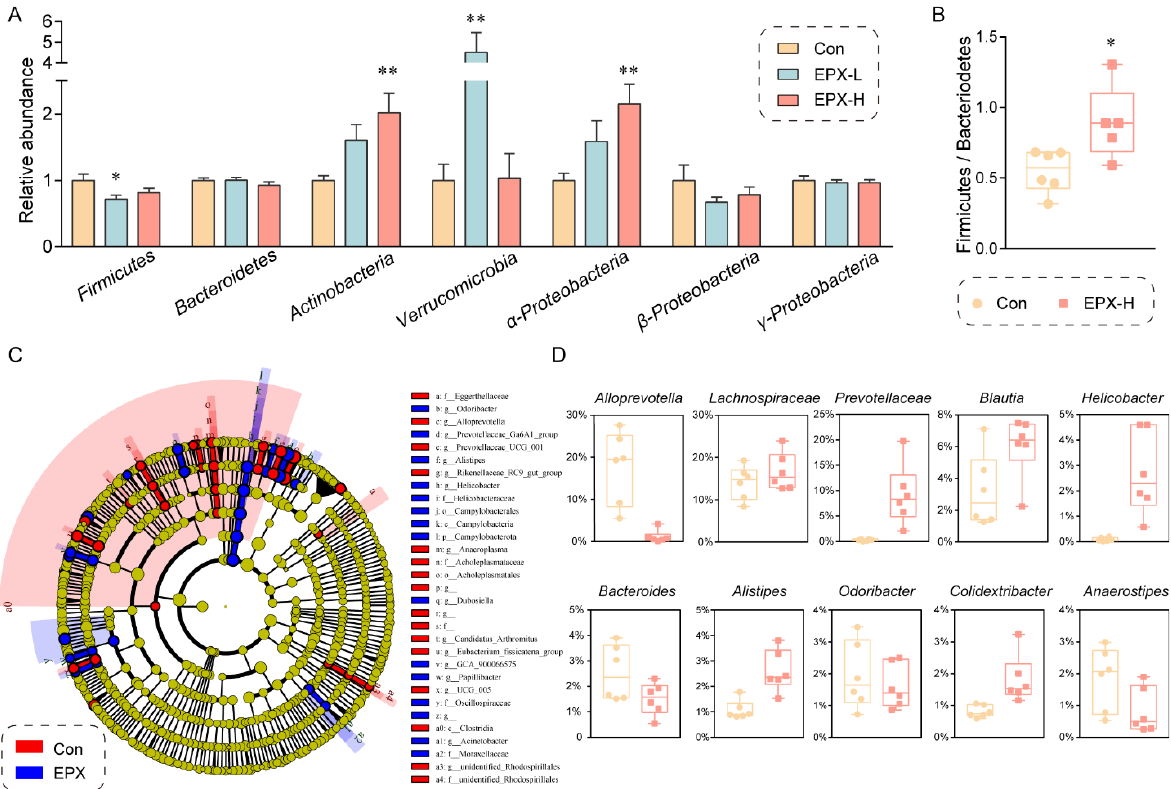
Figure 4. Effects of the oral exposure to EPX on the composition of intestinal microbiota in the colon of mice. ( A ) Relative abundance of the intestinal microbiota at the phylum level. Values are shown as the means ± SEM ( n = 8), and statistical significance: p < 0.05 *; p < 0.01 **. ( B ) The ratio of Firmicutes to Bacteroides. ( C ) Cladogram generated from the LEfSe analysis (LDA score >3). ( D ) The top-10 genera at the genus level.